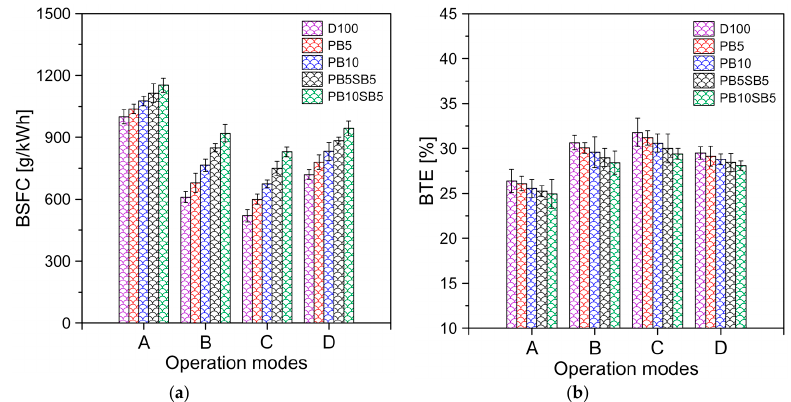
Figure 9. Diagram of ( a ) specific fuel consumption, and ( b ) brake thermal efficiency.